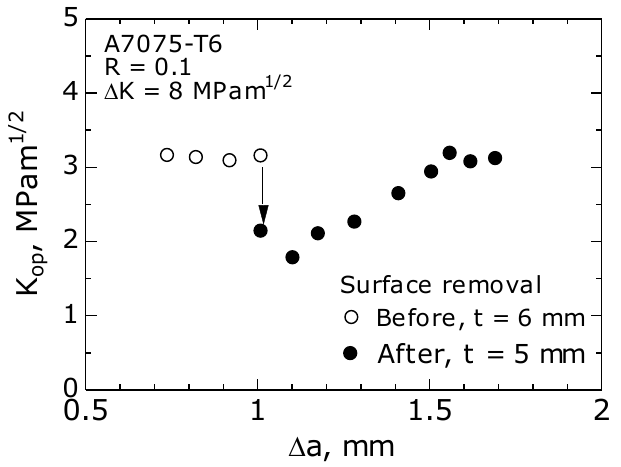
Figure 6. Specimen surface removal experiment (A7075- T6, ΔK= 8 MPa∙m 1/2 , R ＝ 0.1, t = 6 mm).